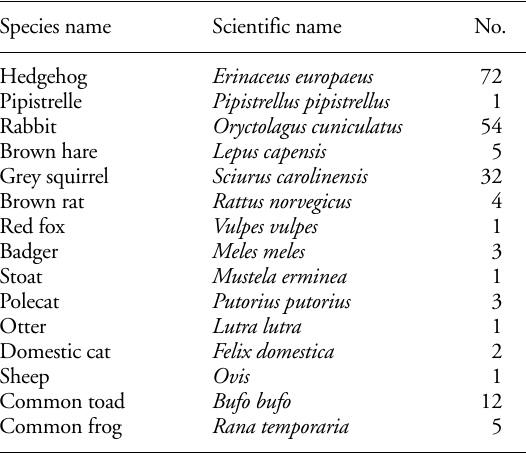
Table 1a. Number of non-bird fatalities in this study.